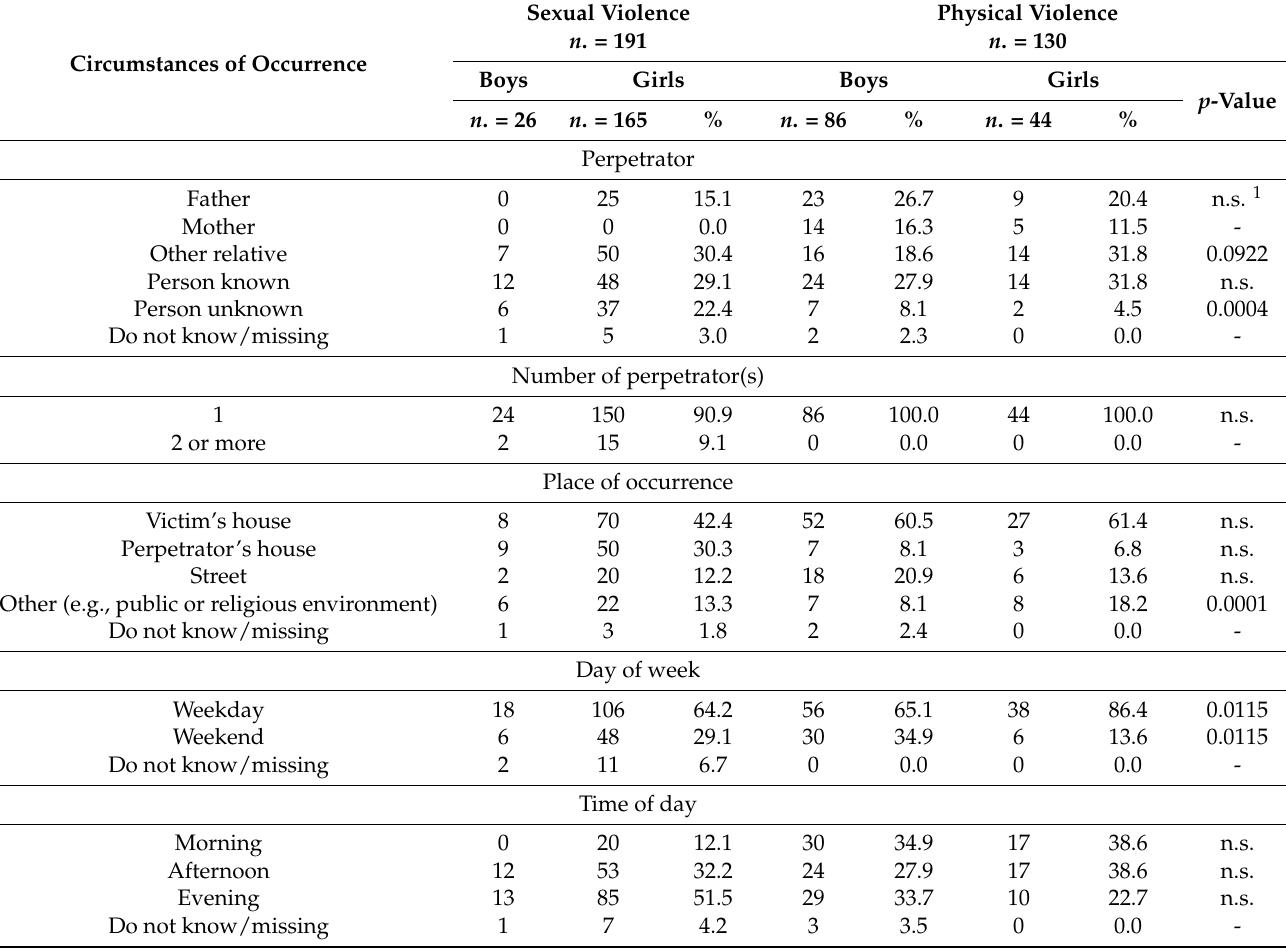
Table 2. Sex-related difference in the circumstances of violence-related injuries among pediatric patients seen at pediatric emergency and forensic medicine at MCH, from 1 January to 31 December 2019.